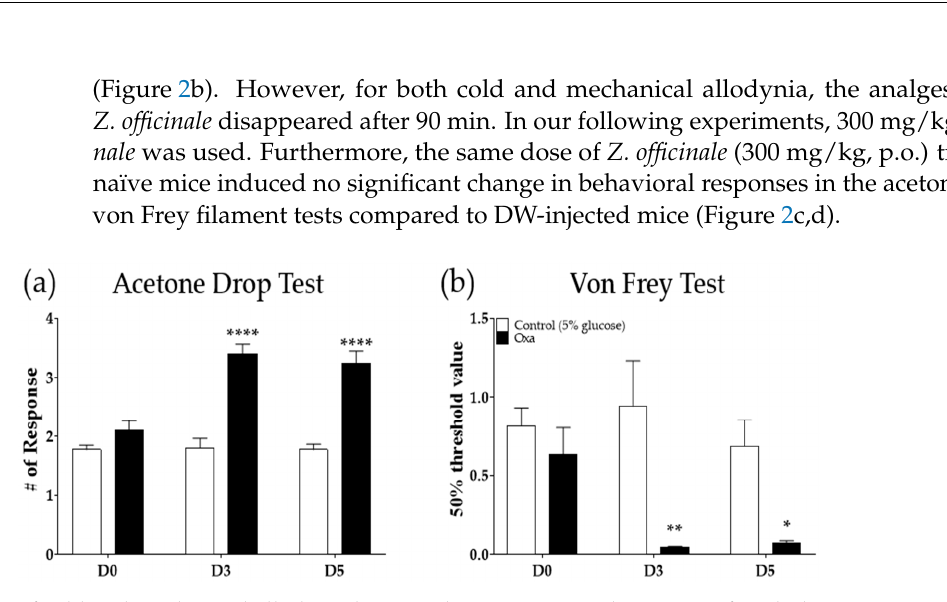
Figure 1. Induction of cold and mechanical allodynia by a single intraperitoneal injection of oxaliplatin in mice. Three to 5 days after a single injection of oxaliplatin (6 mg/kg, i.p.), cold ( a ) and mechanical ( b ) allodynia were produced. Cold and mechanical allodynia were assessed by using the acetone drop and von Frey filament tests, respectively. Control mice were treated with a 5% glucose solution (i.p.). Oxa: oxaliplatin, D0: before the injection of oxaliplatin or 5% glucose, D3: 3 days after the injection of oxaliplatin or 5% glucose, D5: 5 days following the administration of oxaliplatin or 5% glucose. Control (5% glucose): n = 5, oxaliplatin: n = 5. * p < 0.05, ** p < 0.01, **** p < 0.0001 vs. Control with two-way ANOVA followed by Sidak’s post-test for multiple comparisons. Molecules 2021 , 26 , x FOR PEER REVIEW